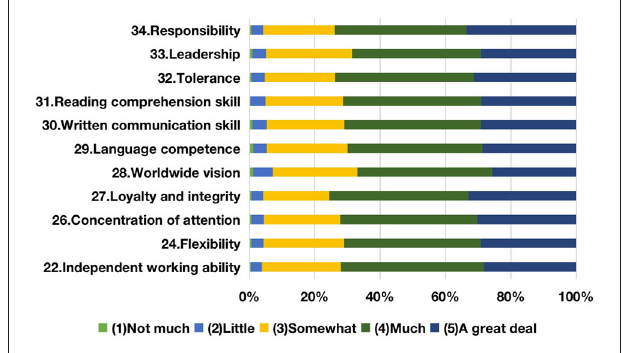
FIGURE 2 | Development of graduates’ soft